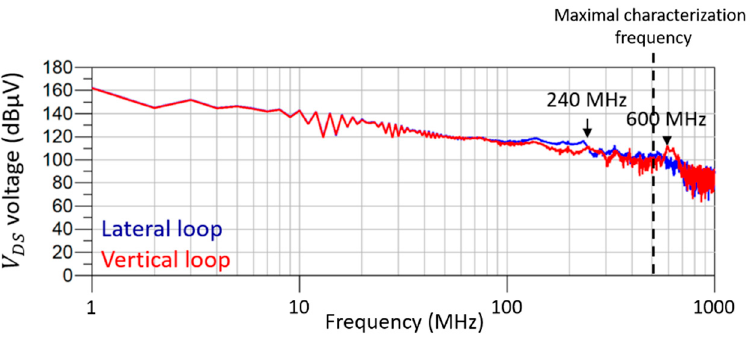
Figure 26. Spectral analysis of GaN transistor T 2 V DS voltage for the two stuided commutation loops.